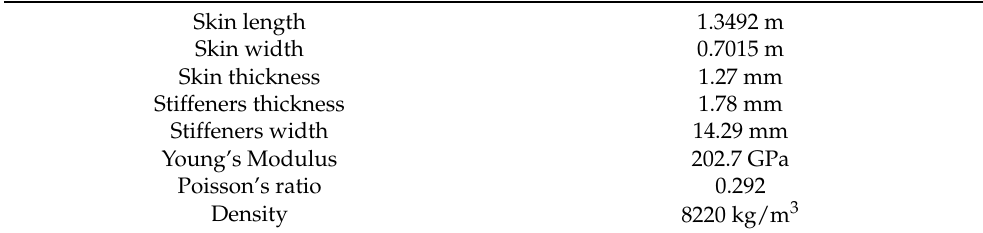
Table 5. Orthogrid panel geometry and material